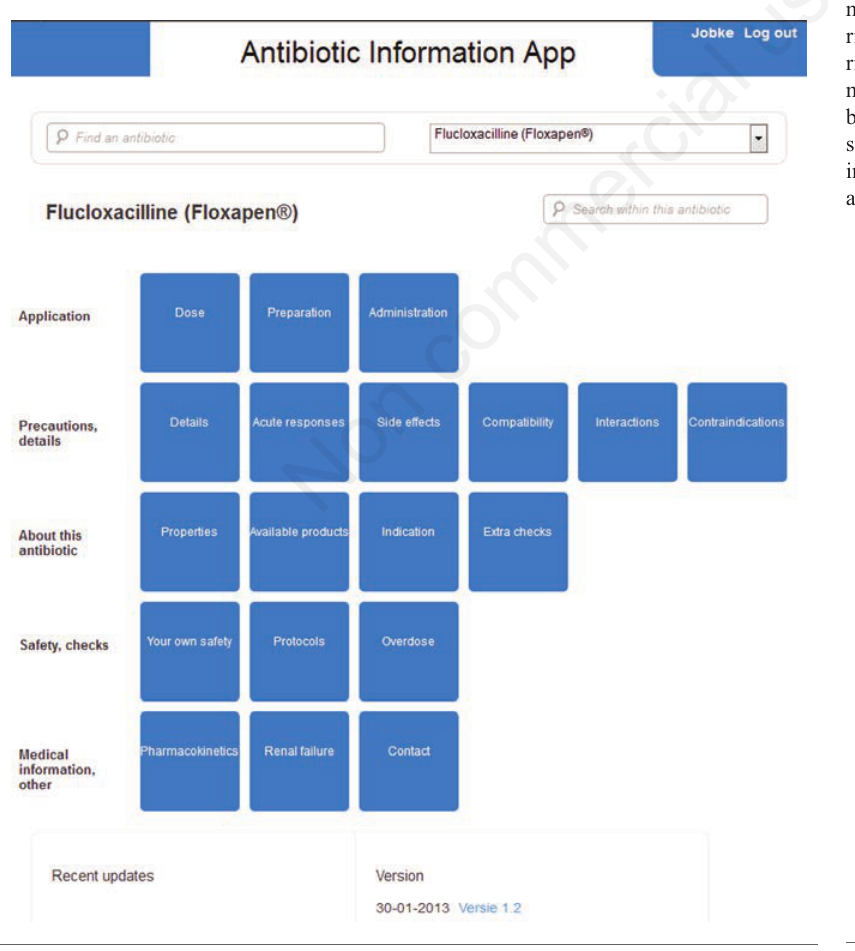
Figure 4. Example of suggestion in a low- fidelity prototype.